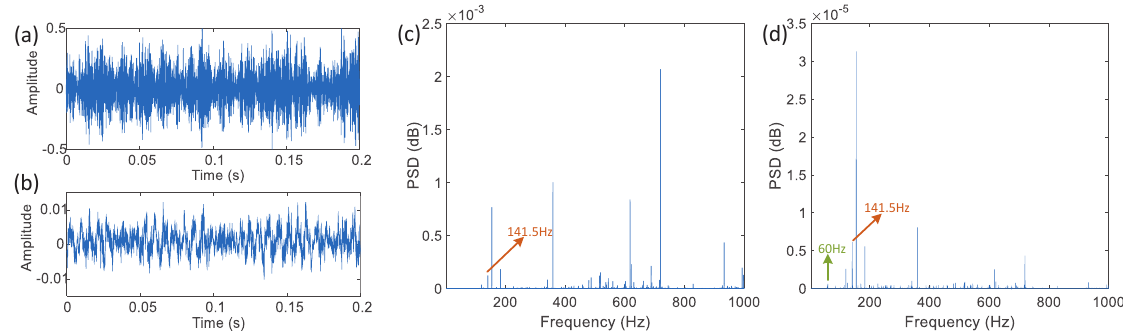
Figure 10. The vibration signal ( a ), the synchronous error ( b ), the power spectral density of rolling element damage using the measured signal ( c ) and the synchronization error ( d